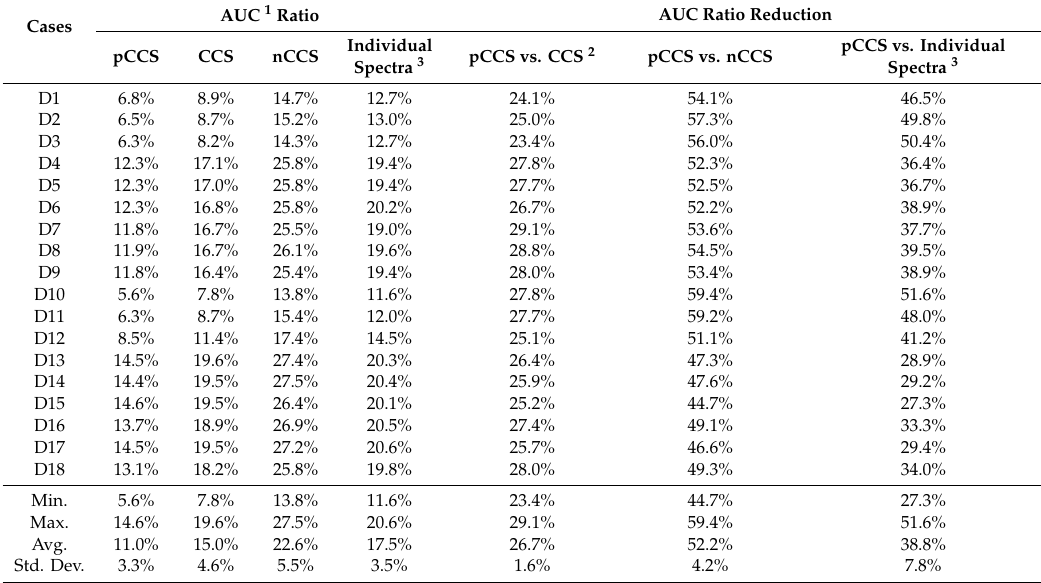
Table 8. Noise related data (AUC ratio) and comparisons of percentage reduction between the s the non-coherent (nCCS), coherent (CCS), and poly-coherent (pCCS) composite spectra, and the summary of the four individual spectra, for each of the 18 cases under